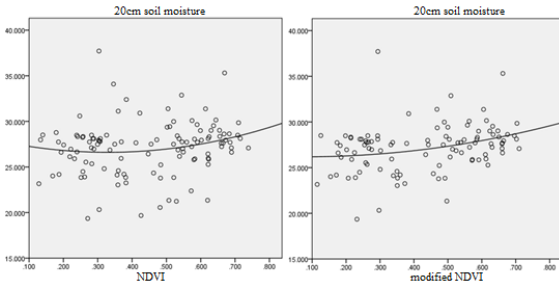
Figure 4. Regression curve of 20cm soil moisture on NDVI and modified NDVI in 2.10 in central Henan